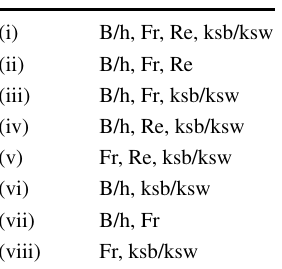
Table 3 The variables of each input combination